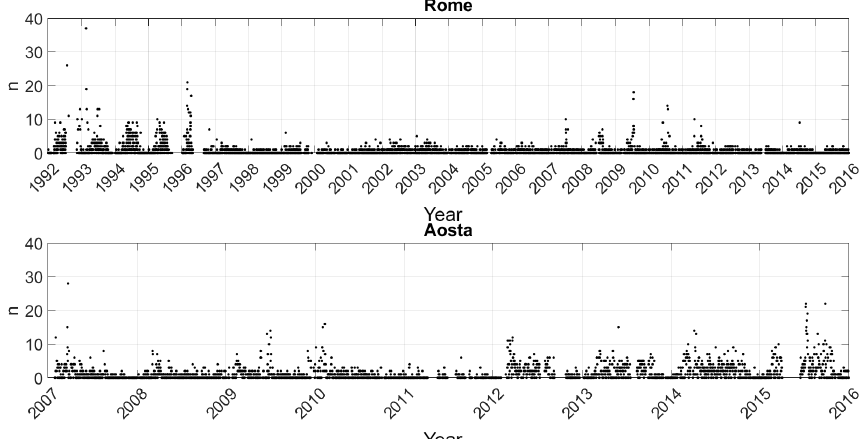
Figure 10. Time plot of the difference ( n ) between the number of individual ozone values per day calculated by O3Brewer and those by BPS.